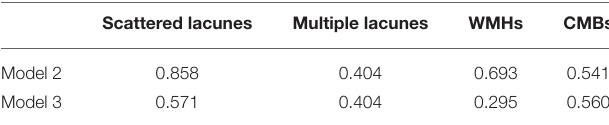
TABLE 7 | Hosmer–Lemeshow (H–L) test of models 2 and 3 in subtypes of CSVD.